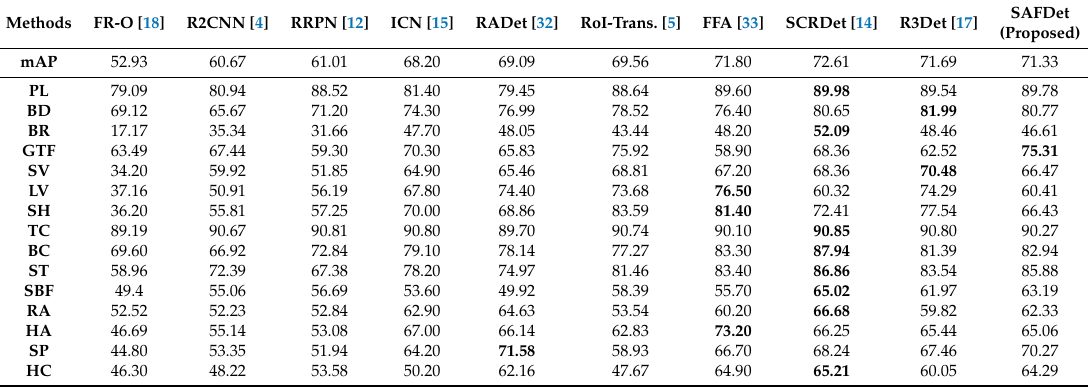
Table 3. Quantitative comparison with the state-of-the-art methods on the task 1 of DOTA